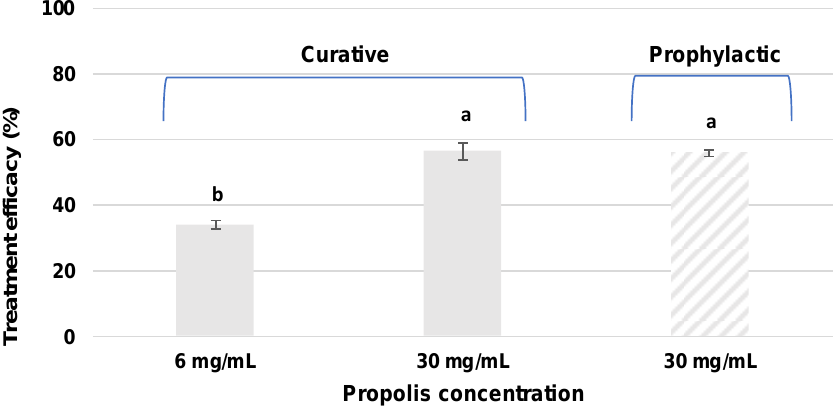
Figure 4. Reduction of lesions diameter (treatment efficacy) relative to control after 14 days of incubation at 20 °C in the curative (left) and prophylactic (right) assays Results are presented as means ± standard deviation of two replicates. Different letters denote significant differences among treatments efficacy ( p < 0.05).